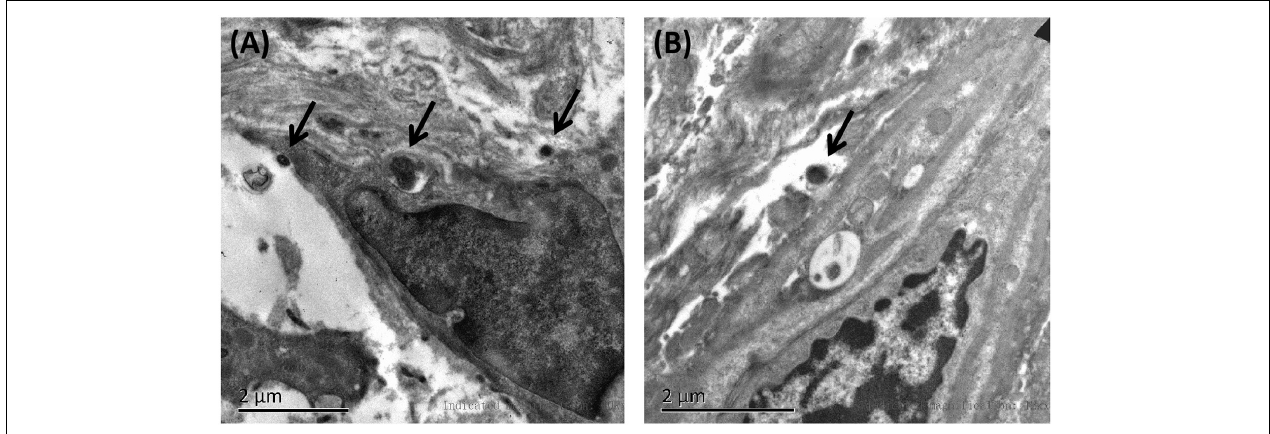
FIGURE 4 | Representative images of skin biopsies. Electron microscopy of skin biopsies from the proband carrying R133S (A) and R607H (B) , showing deposits of GOM (black arrow). TABLE 4 | In silico analysis, allele frequency, and classification of untypical NOTHC3 variants. Variant In silico analysis Frequency in GnomAD GOM deposit in biopsy Classification a